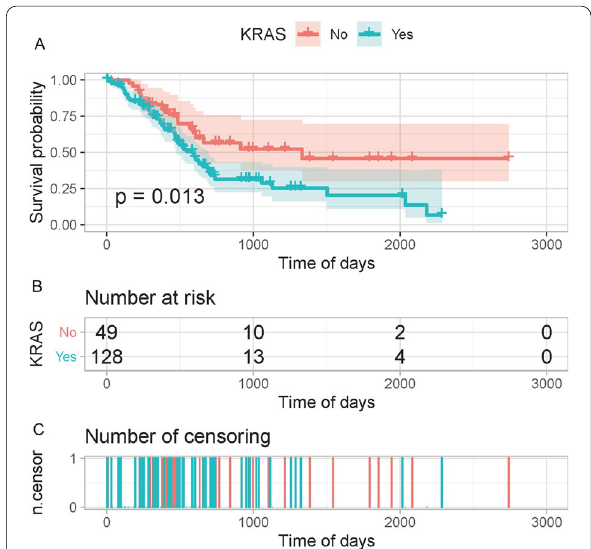
Fig. 1 Survival analysis of KRAS mutation: A survival curve. B Number of individuals at risk (possibility of death) over time in both groups of samples. C Number of dead patients at each time